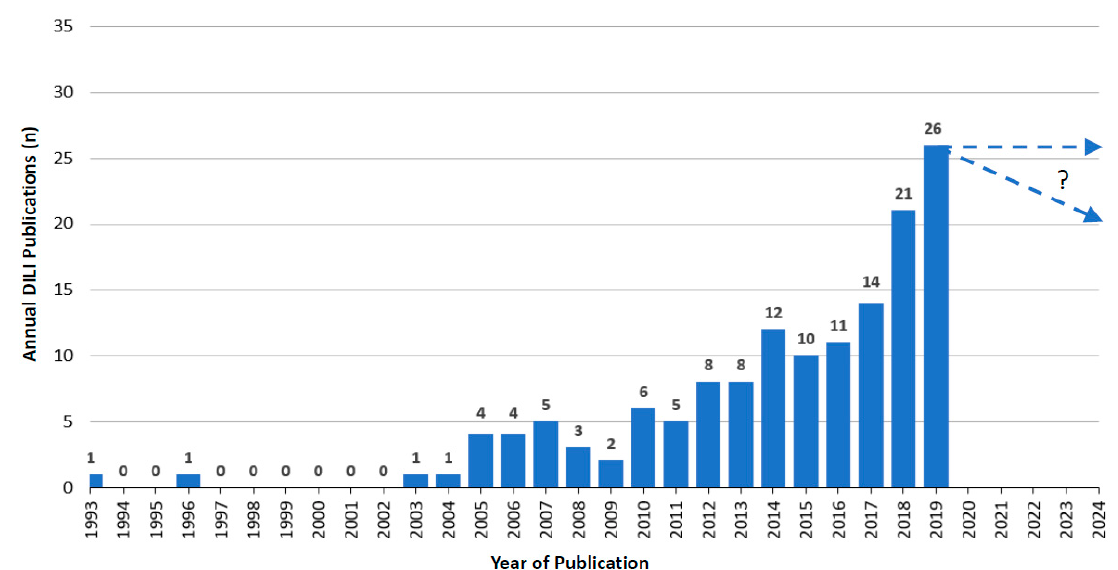
Figure 1. Annual publications of DILI cases assessed for causality by RUCAM as reported since 1993. This figure is derived from a previous report of the authors [7], which provides many details.